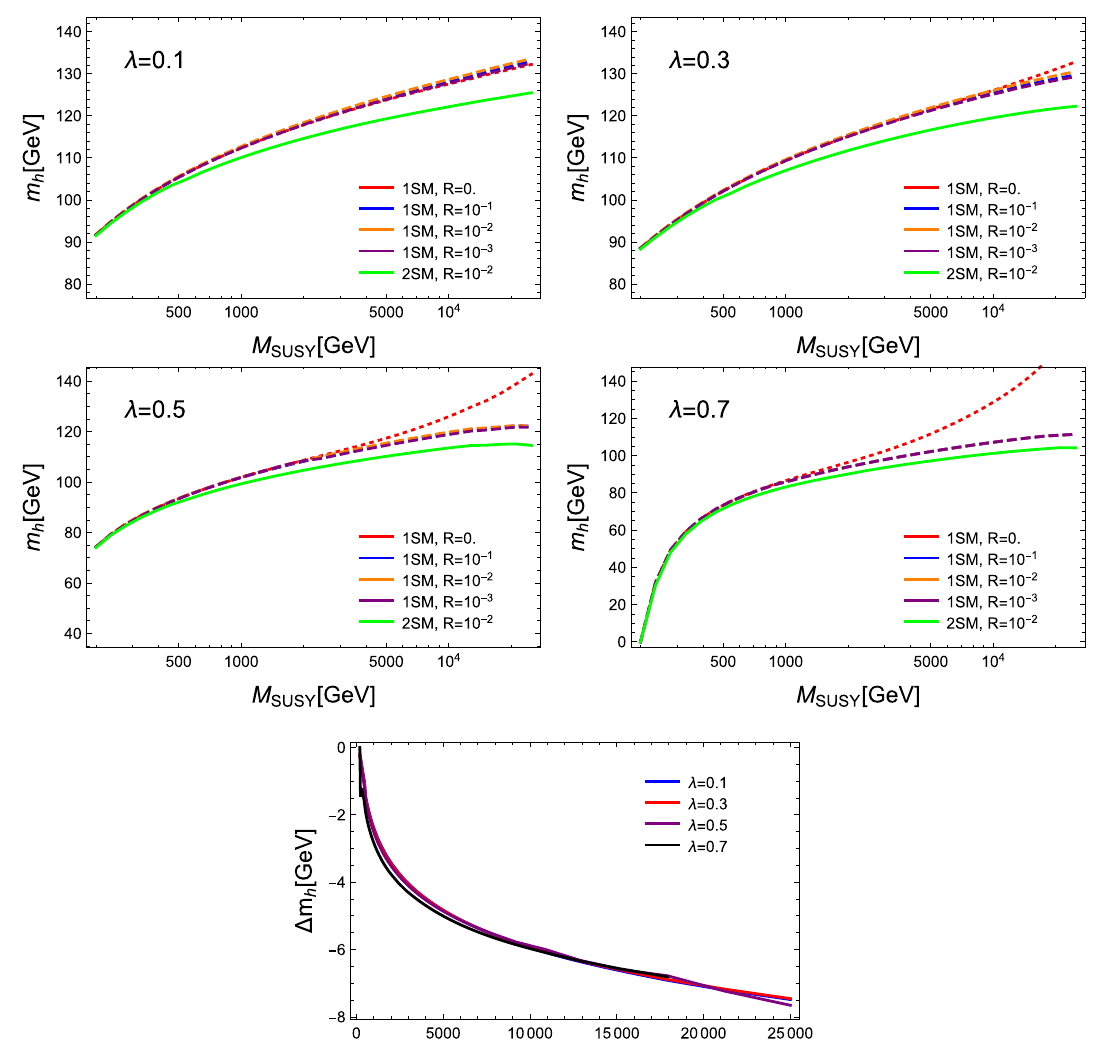
R = 10 − 1 , 10 − 2 , 10 − 3 , while for the green line the two-scale matching (2SM) was used together with a Higgs mass calculation in the effective SM. The third row shows the difference (cid:9) m h between the one-scale and two-scale matching (both with R = 10 − 2